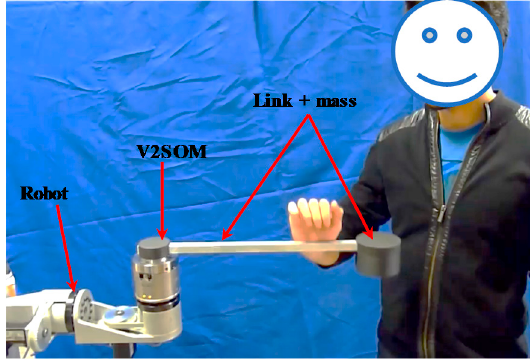
Figure 16. Experimental setup.